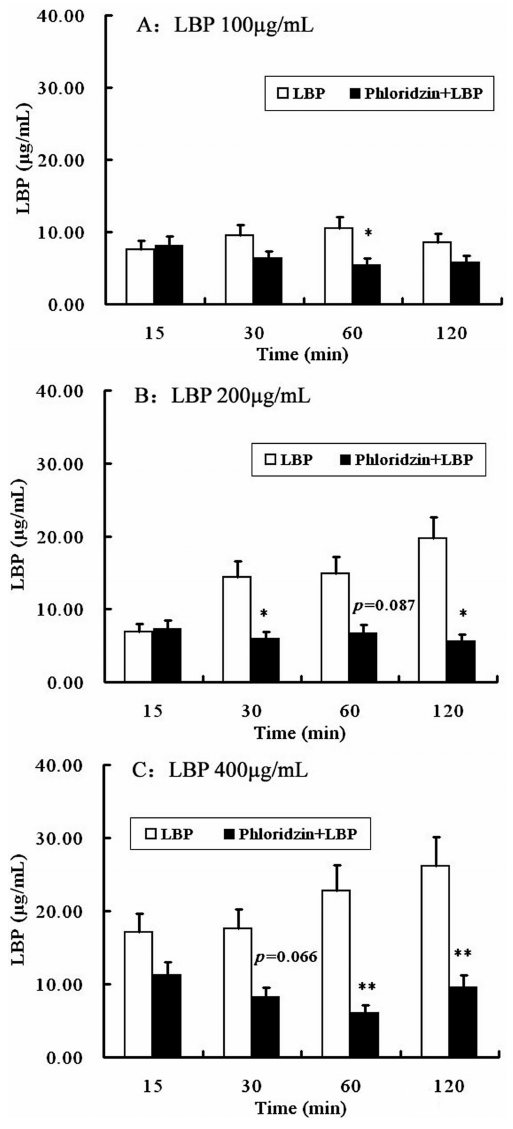
Figure 7. The uptake of LBP after SGLT-1 inhibition in Caco2 cells. ( A ) Caco2 cells were treated with LBP (100 μ g/mL) for 120 min after phloridzin (2 mmol/L) pretreating; ( B ) Caco2 cells were treated with LBP (200 μ g/mL) for 120 min after phloridzin (2 mmol/L) pretreating; ( C ) Caco2 cells were treated with LBP (400 μ g/mL) for 120 min after phloridzin (2 mmol/L) pretreating. The data are presented as the mean ± SD ( n = 3). The asterisk indicate a significant difference among samples, * p < 0.05; ** p < 0.01 (Student’s paired t